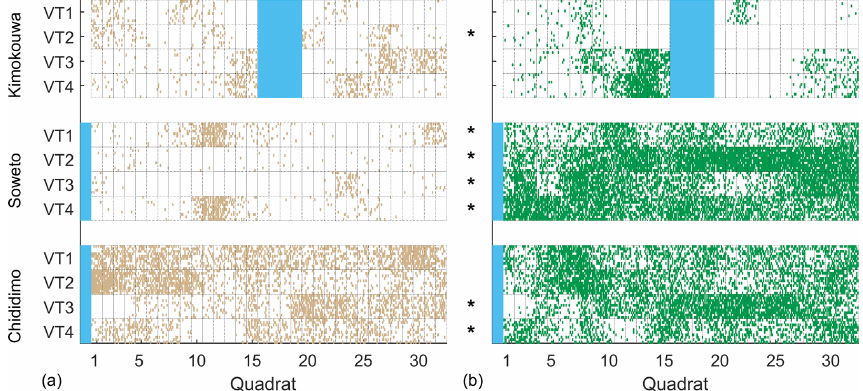
Figure 4. Representation of percent vegetative cover for each transect at each sand dam during the (a) dry season and (b) rainy season. The stars indicate a significant difference ( p< 0 . 05) between the wet and dry season vegetative cover for that transect. The solid colour indicates the location of the stream relative to the transect. VT1 is downstream of the dam; VT2–4 are upstream.